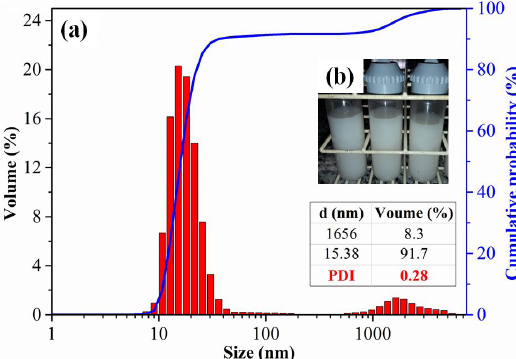
Figure 9. (a) Particle size distribution examined by DLS analysis and (b) colloidal suspension of ZnO.